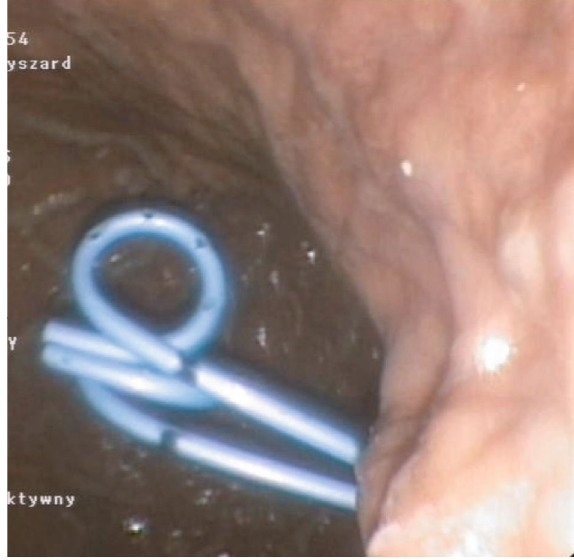
Figure 4: Passive transmural drainage of a pancreatic pseudocyst with two plastic double-pigtail